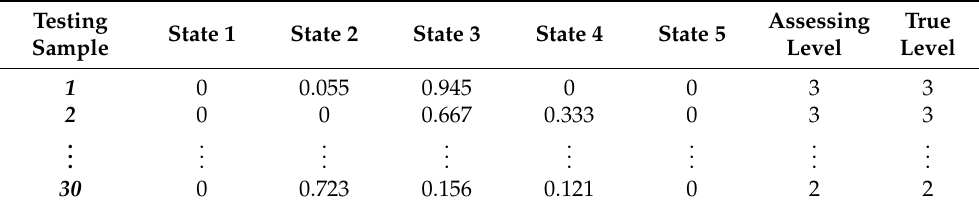
Table 11. Posterior probability distribution and grade of marine disaster